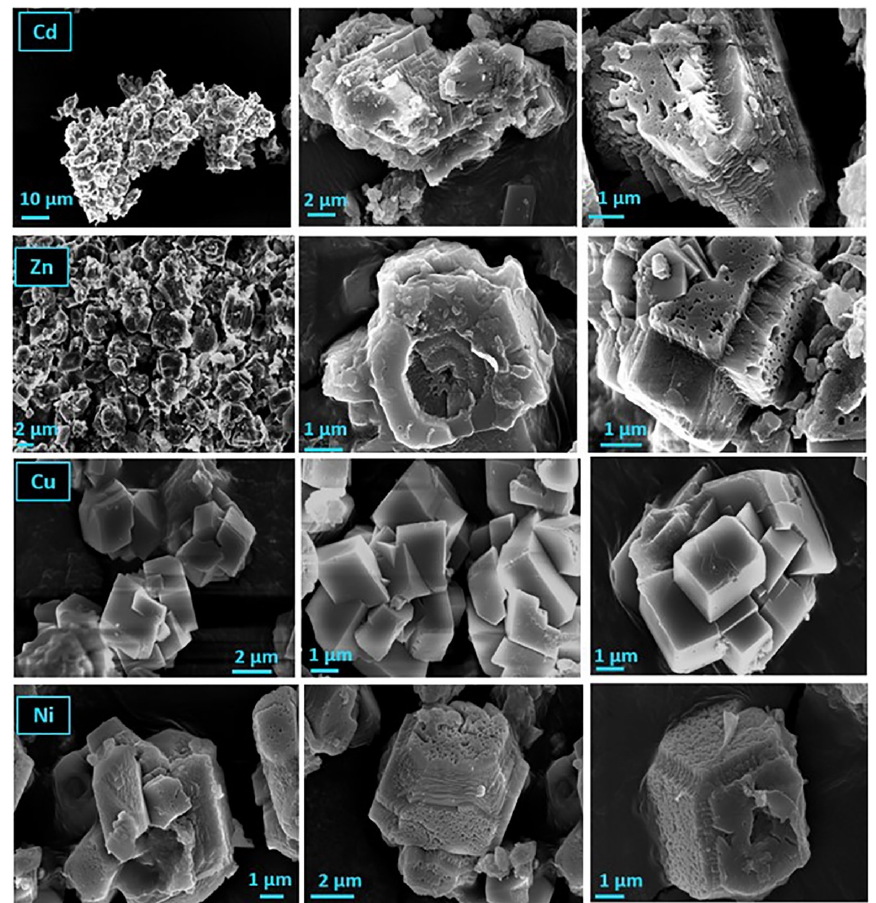
Figure 15. SEM pictures of calcium carbonate precipitated in supersaturated solutions in the presence of heavy metals (Zn or Cd or Ni or Cu), 20 mL of active A. obliquus culture with modified medium and illumination.; pH 8.5, 25 °C, 0.15 M of NaCl.